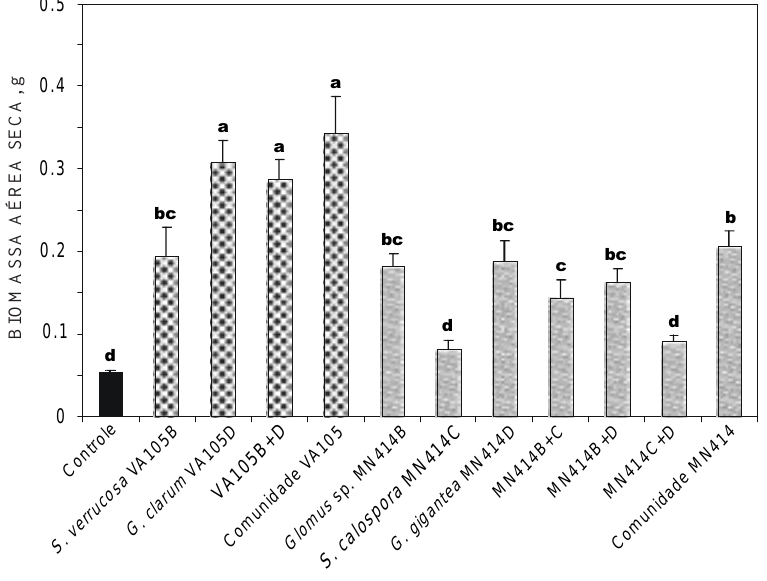
Figura 3. Biomassa aérea seca de plantas de trevo vermelho inoculadas com FMAs isolados ou em combinação. Colunas representam a média de cinco repetições e barras representam o erro-padrão.